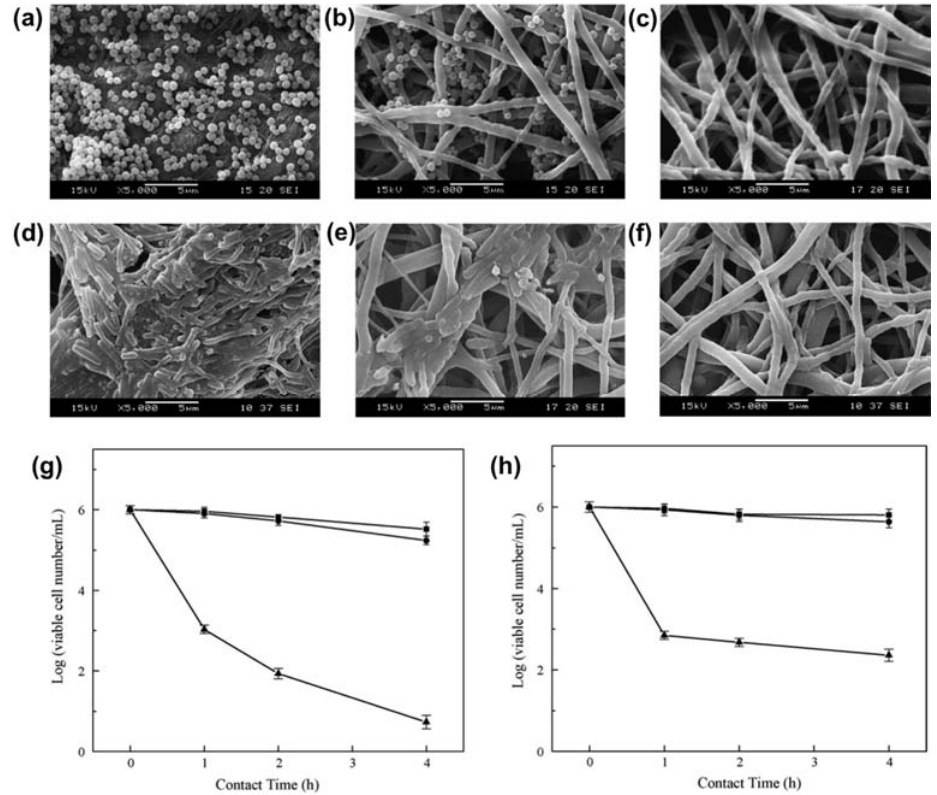
Figure 5. Scanning electron microscopic images of ( a , d ) filter paper (control), ( b , e ) pristine, and ( c , f ) modified polyurethane (PU) fibrous membranes after immersed in phosphate-buffered saline (PBS) suspension of ( a – c ) S. aureus , or ( d – f ) E. coli for 4 h. Scale bar = 5 μ m. ( g ) Cell viability study of S. aureus , and ( h ) E. coli as a function time in contact with control (filled square), pristine (filled circle), and modified PU fibrous membranes (filled triangle). Reproduced with permission from [153].